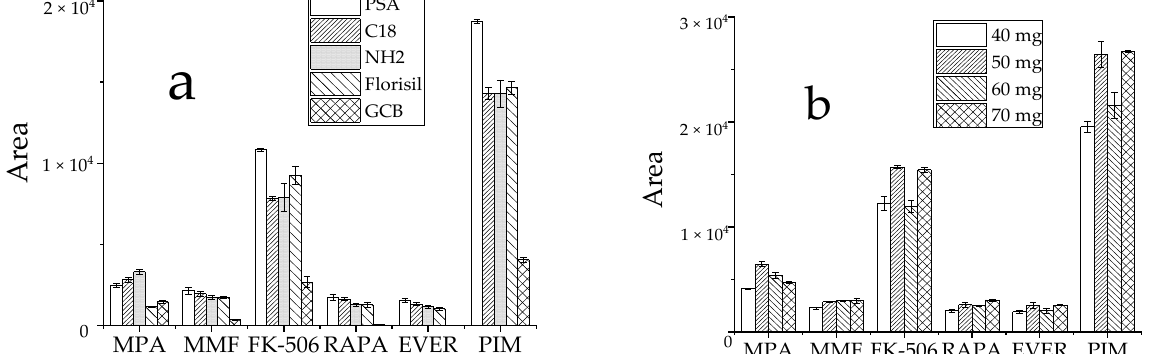
Figure 5. Effect of purifying agent on the recovery peak area of analyte, ( a ): types of purifiers; ( b ): dosage of PSA.